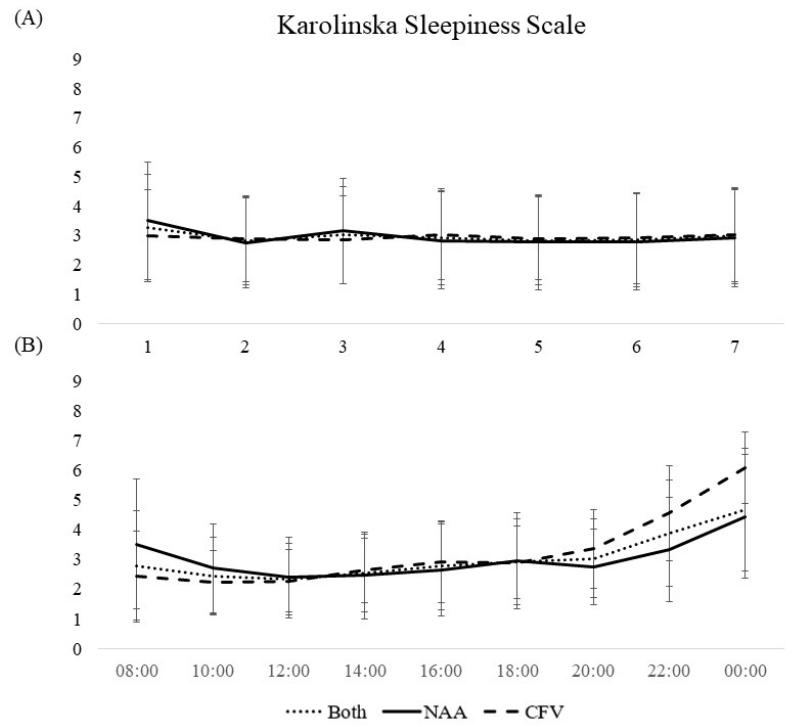
Figure 6. Mean scores of Karolinska Sleepiness Scale among pilots in the Norwegian Air Ambulance (NAA; n = 25), Christophorus Flugrettungverein (CFV; n = 22), and both groups collapsed. ( A ) During a 7-day workweek and ( B ) between 08:00–00:00 on workdays. Error bars represent standard deviation. For both pilot groups collapsed, day 2 ( p < 0.001) and day 3 ( p < 0.05) had lower KSS scores compared with the reference day (day 1) during the workweek. For time of day, the KSS scores at 10:00 ( p < 0.05) and 12:00 ( p < 0.01) were lower, while the scores at 18:00 ( p < 0.05), 20:00 ( p < 0.01), 22:00 ( p < 0.001), and 00:00 ( p < 0.001) were higher compared with the reference time (08:00 h). No difference between the pilot groups was evident ( b = − 0.039, p =